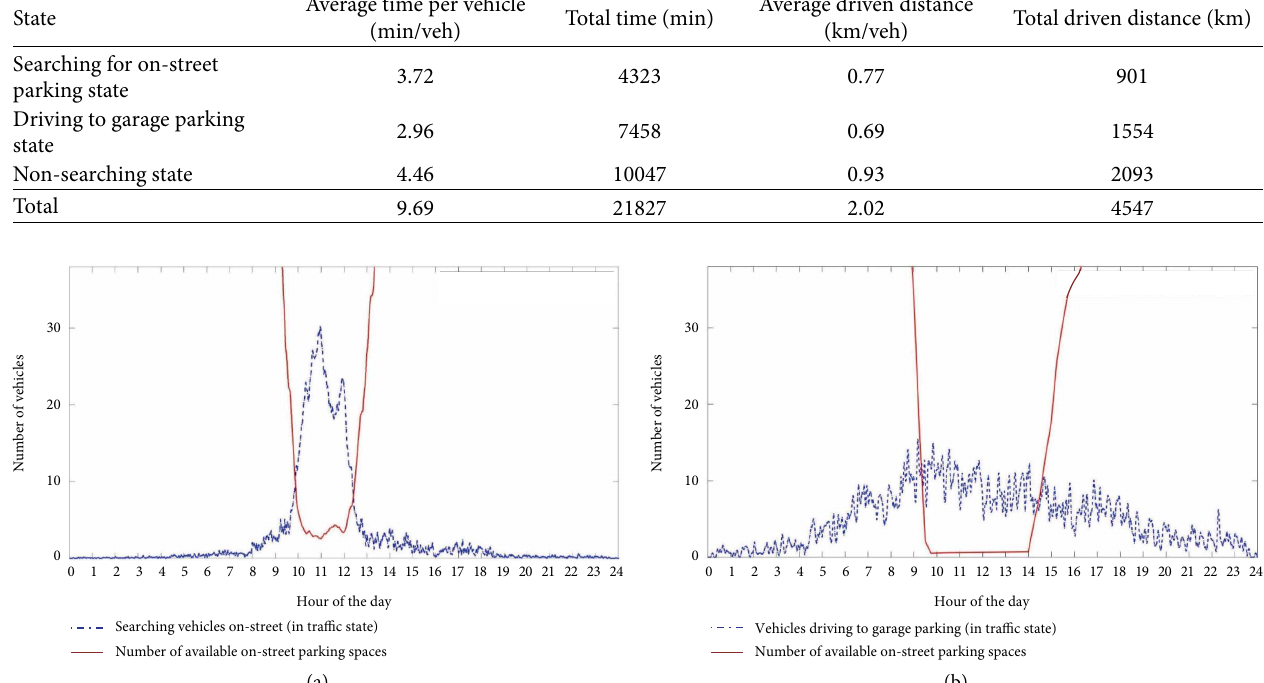
Figure 7: On-street and garage parking demand and supply over a typical working day. (a) Searching vehicles and available on-street parking. (b) Vehicles driving to garage and available garage